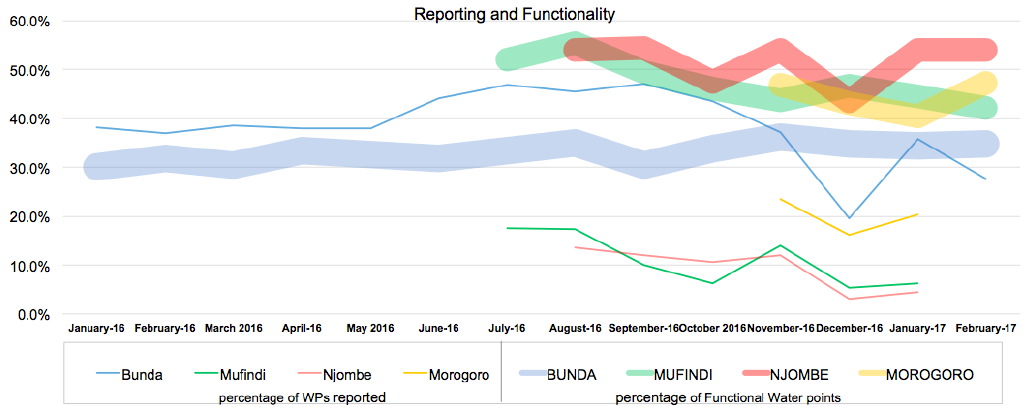
Figure 11. Water Point (WP) Reporting status in the districts.